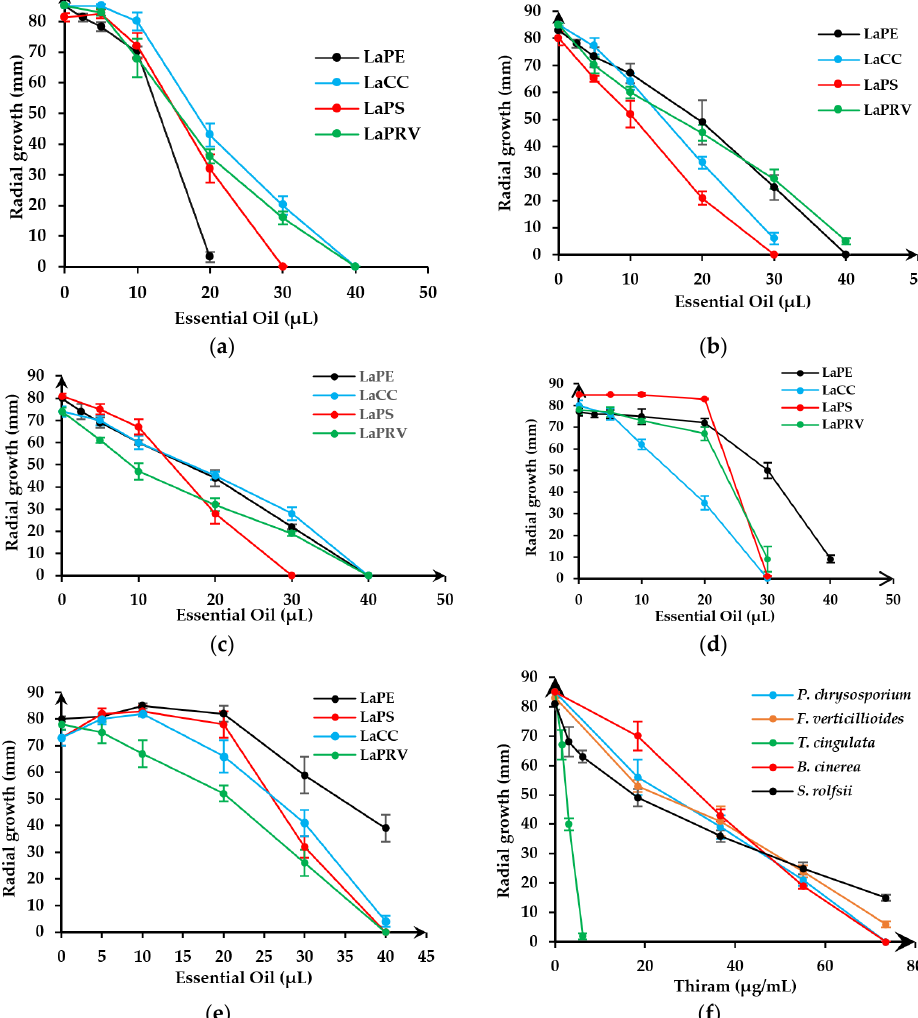
Figure 3. Toxic effect of different concentrations of lavender EOs on the radial growth of P. chrysosporium ( a ), S. rolfsii ( b ), B. cinerea ( c ), T. cingulata ( d ) and F. verticillioides ( e ). Fungal growth on Thiram